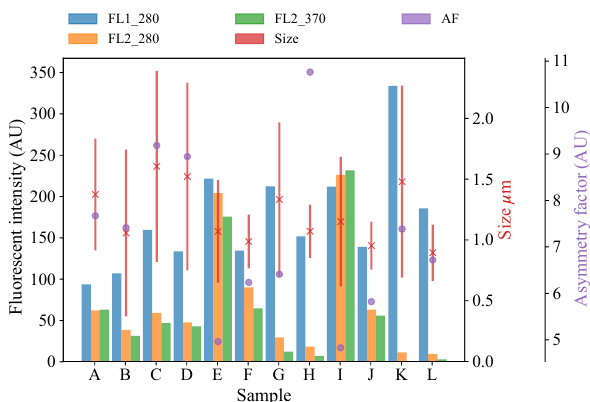
Figure 5. Average fluorescent characteristics for the bacterial sam- ples collected in 2008. The error bars in red indicate a range of ± 1 σ for each sample.